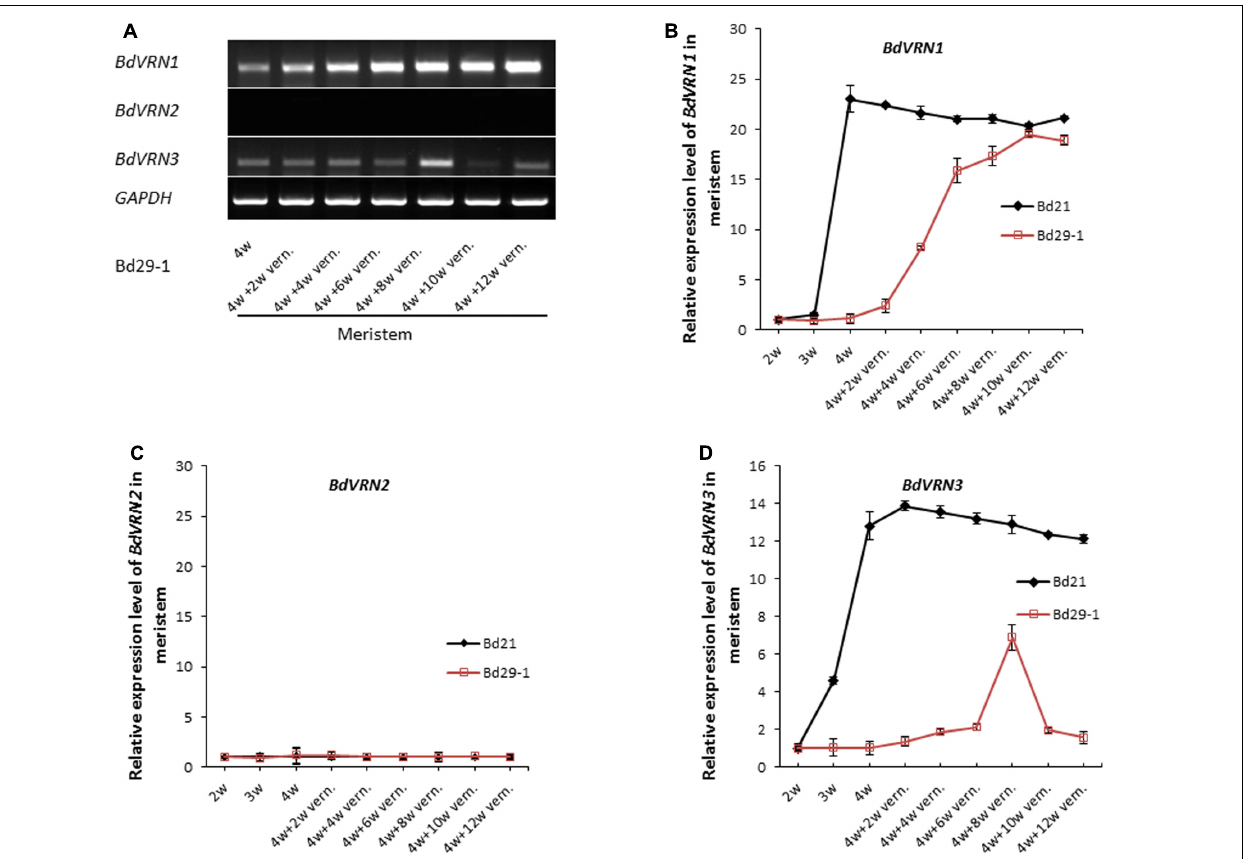
FIGURE 2 | Expression of BdVRN genes in meristems of the non-vernalization-requiring Bd 21 and vernalization-requiring Bd29-1 accessions. (A) BdVRN gene expression in meristems of 4-week-old seedlings of Bd29-1 that were vernalized for 2, 4, 6, 8, 10, or 12 weeks. BdGAPDH was used as loading control. (B–D) Relative expression levels of BdVRN1 , BdVRN2, and BdVRN3 genes in meristems of Bd21 and Bd29-1. Prior to vernalization, plants were grown at a greenhouse (25 ◦ C, 16/8 h day/night). Four-week-old seedlings were transferred to a growth chamber at 4 ◦ C and 8/16 h (day/night) for vernalization treatment. Meristems were harvested after 2, 4, 6, 8, 10, or 12 weeks of vernalization treatment. Error bars represent the standard deviation from independent plants.